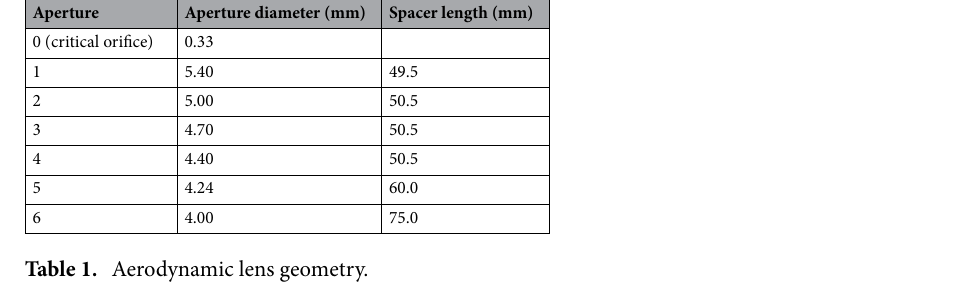
Table 1. Aerodynamic lens